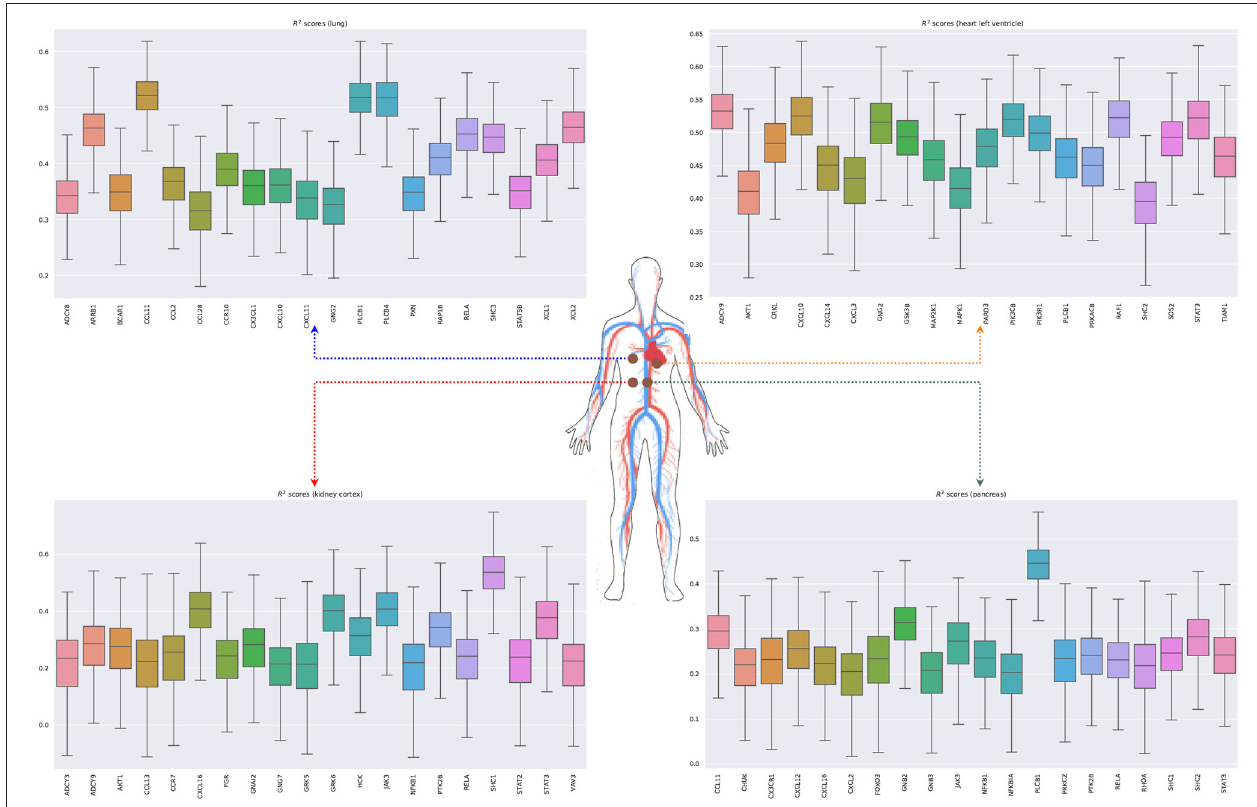
FIGURE 7 | Bootstrapped R 2 scores for several cytokines and receptors for lung, heart (left ventricle), kidney (cortex), and pancreas. For each tissue type, we show the top 20 predicted cytokines. The input variables are the expressions of genes in whole blood belonging to the chemokine, TNF, and TGF- β pathways.